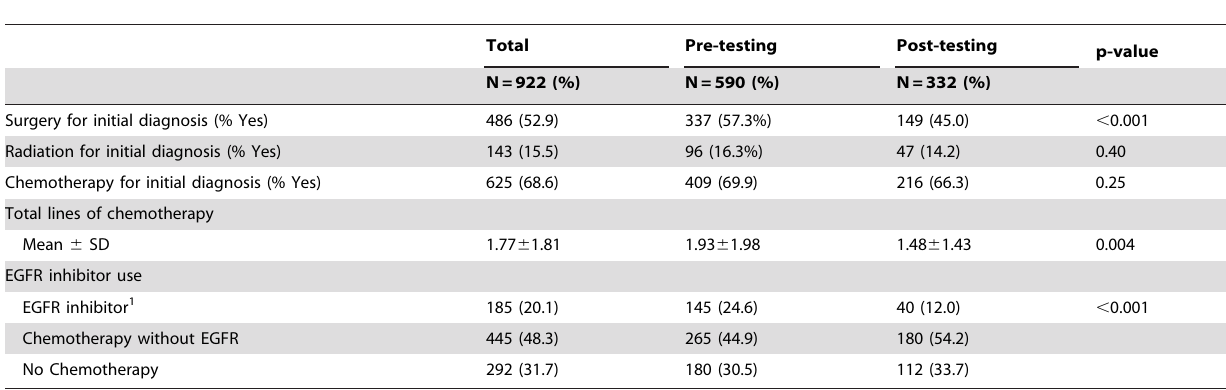
Table 3. Treatment patterns for 922 metastatic colorectal cancer patients diagnosed at Stage IV by